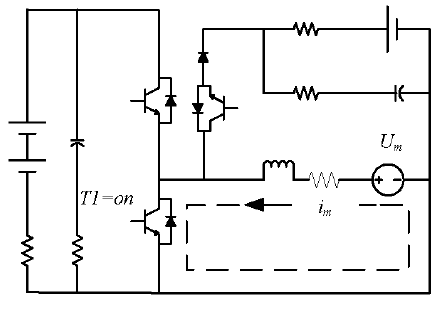
Figure 4. The currents during the energy resuming